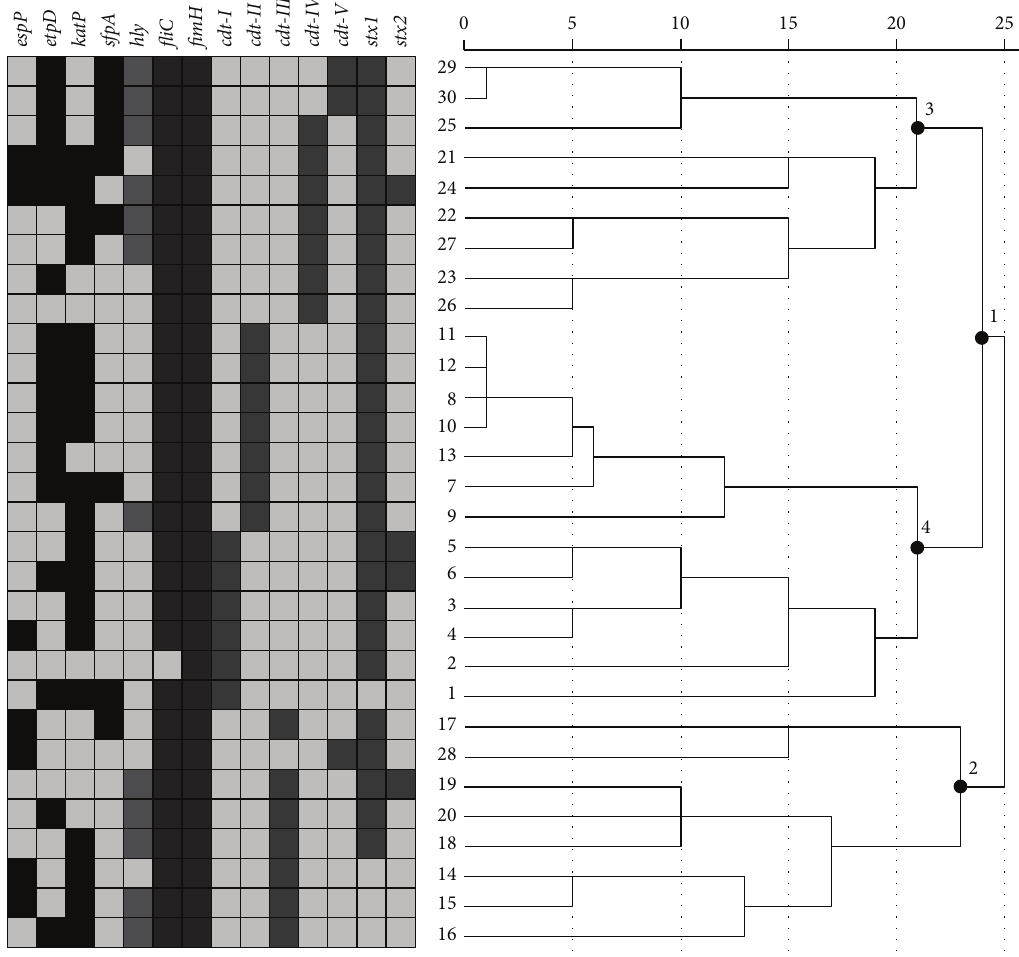
Figure 1: Dendrogram using average linkage between groups: This figure illustrates hierarchical clustering analyses between 30 examined clinical isolates which are clustered based on virulence-associated factors including virulent plasmid, phage, chromosomal, and pathogenicity islandgenes.Attheendofeachbranchthenumbersindicatestrains,asmovingtotherightrelativedistancebecomesmoreapparent.Distances are more distinct by using a 0 to 25 scale along the top of the chart. Depicted table which is in front of the tree illustrates the comparative patterns of cooccurrence and presence of virulent genes in different strains (light gray scale shows gene loss and different dark gray scales show different virulent genes genesis). Defined pattern can be observed for each cdt -type isolates based on other virulent